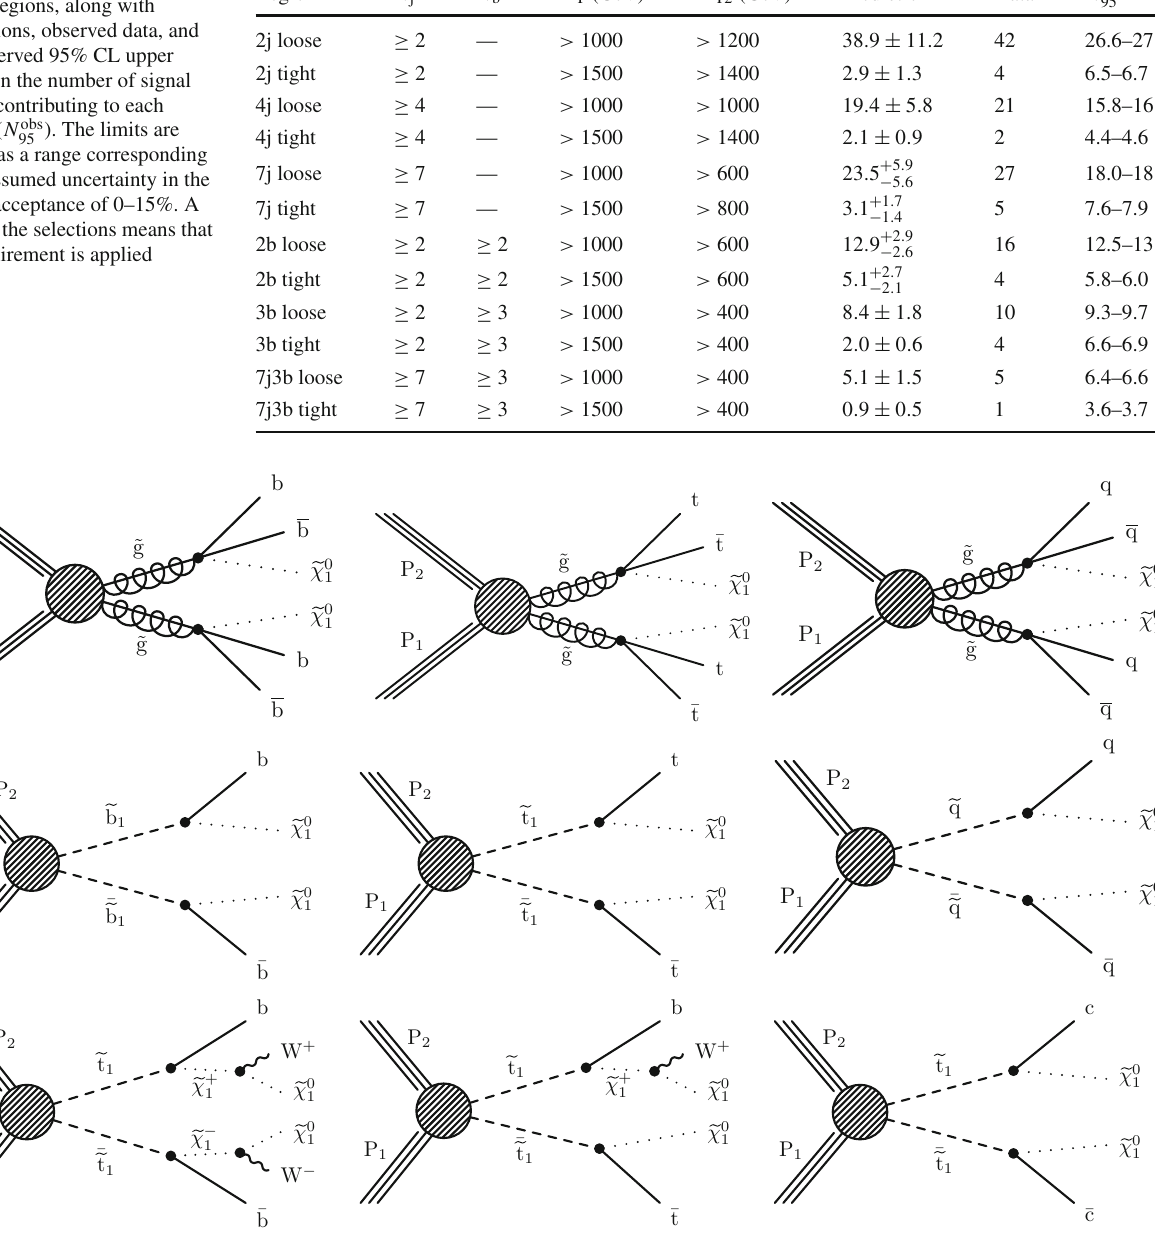
of direct top squark production with different decay modes. For mixed decay scenarios, we assume a 50% branching fraction for each decay mode